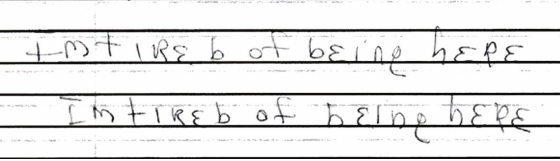
Figure 2: Mirror image of